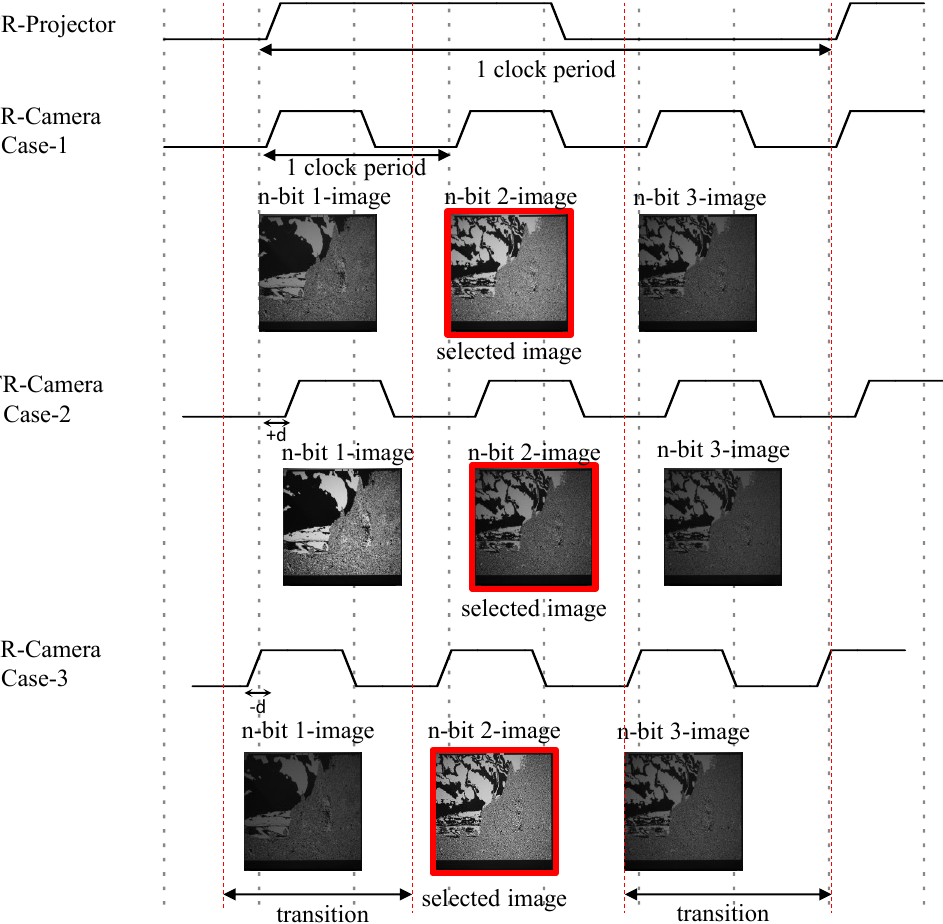
Figure 7. Image selection for software-based